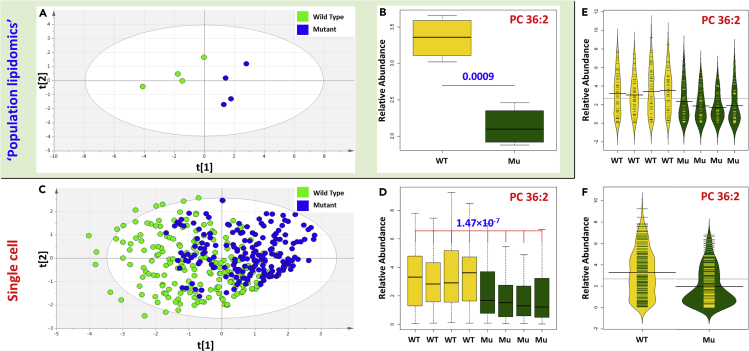
Comparison of the Information Provided by Population and Single Cell Lipid Profiling Approaches(A) PLS-DA scores plot of population level lipid profiling comparing wild-type and A53T mutants (Mu).(B) Boxplot of the abundance of PC 36:2 in wild-type and A53T mutants (Mu); p value calculated using generalized linear model.(C) PLS-DA scores plot of single cell lipid profiling comparing wild-type and A53T mutants (Mu).(D) Boxplots of the abundance of PC 36:2 in each biological replicate, p value calculated using generalized linear model.(E) Beanplot showing the relative distribution of the abundance of PC 36:2 in each biological replicate cells where each line represents the abundance measured in a cell and the width of the outline represents the density of samples.(F) Beanplot showing the relative distribution of the abundance of PC 36:2 in combining all wild-type and all mutants where each line represents the abundance measured in a cell and the width of the outline represents the density of samples. All p values were calculated using generalized linear models.Mu, SNCA-A53T mutant dopaminergic neurons; PC, glycerophosphocholine; PLS-DA, partial least squares-discriminant analysis.